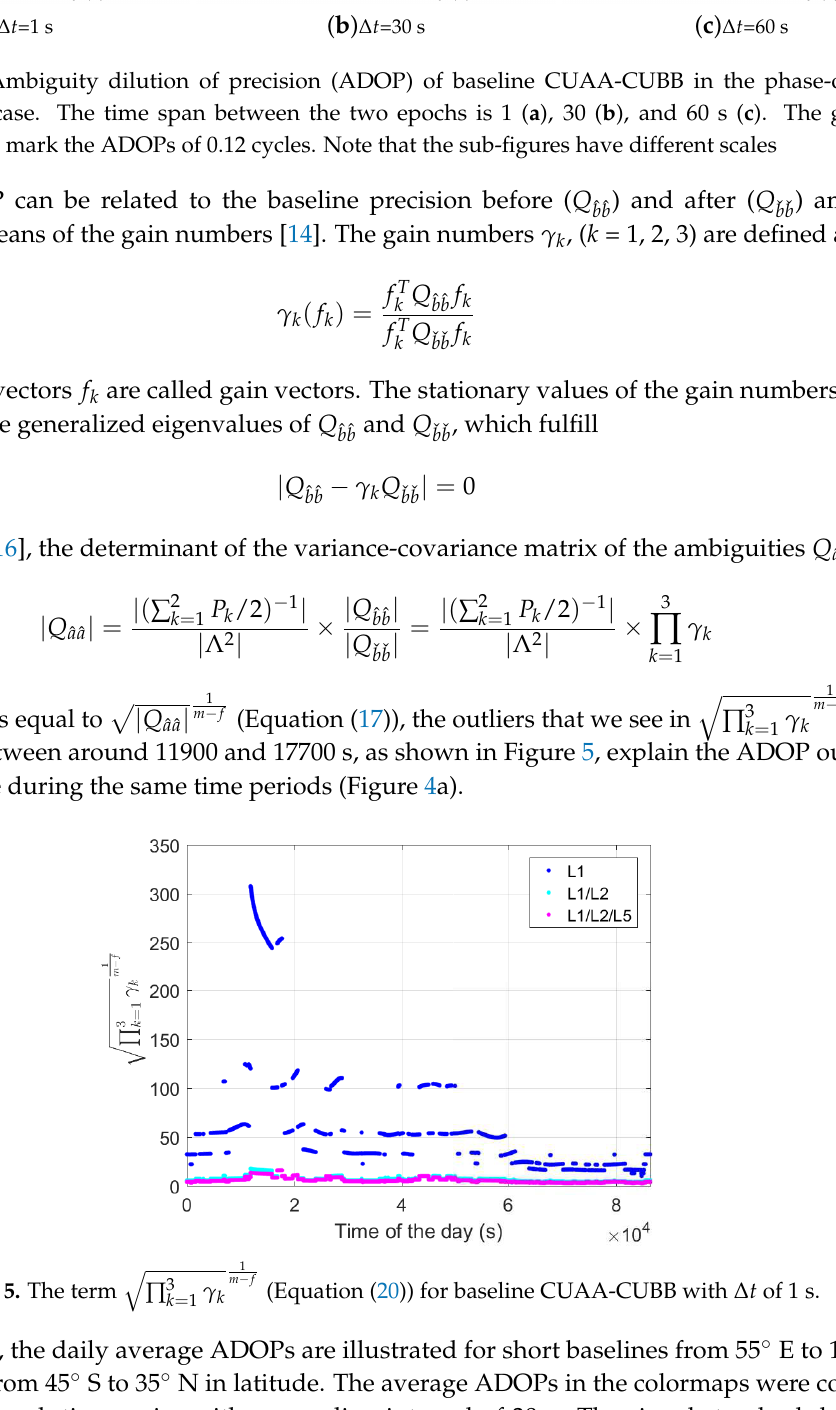
(cid:113) ∏ 3 γ k = 1